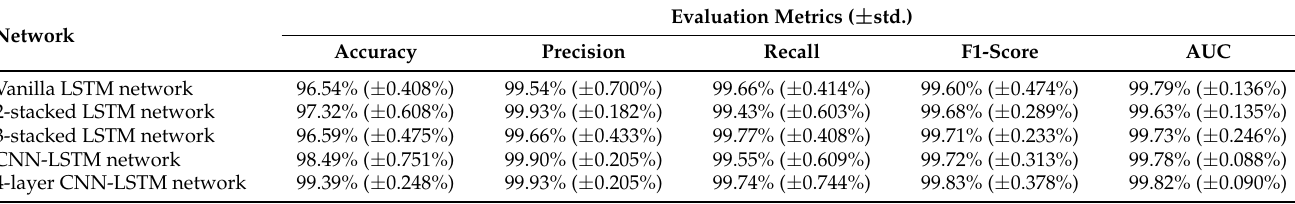
Table 8. Performance metrics of five LSTM networks used in the experiment by OW sample generation and 10-fold cross validation protocol.